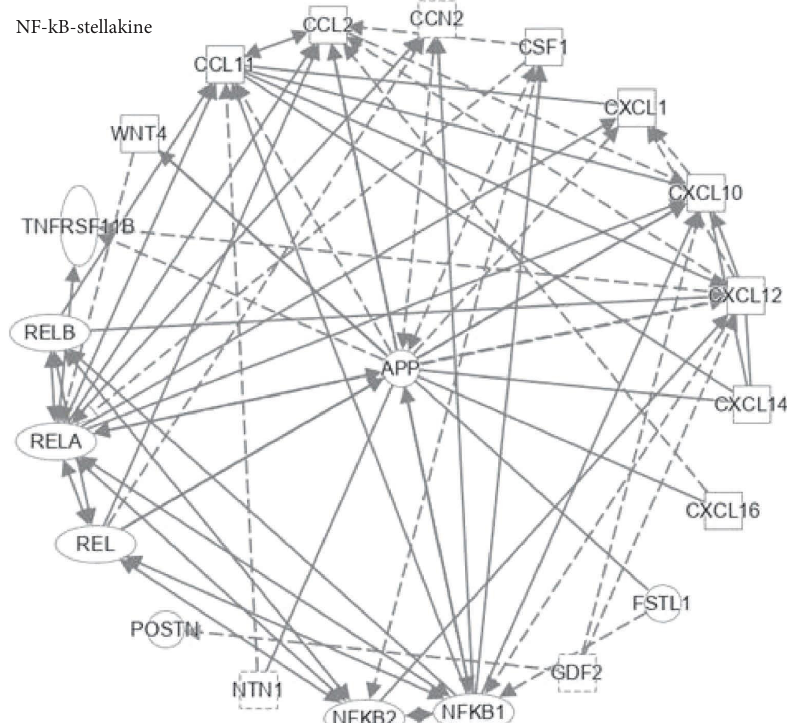
Figure 2: NF- κ B and stellakine. IPA showed the molecular pathways of stellakines and NF- κ B network. APP: amyloid precursor protein, CC chemokines (such as CCL2, CCL11), CSF1: colony stimulating factor 1 (also known as M-CSF), CTGF: connective tissue growth factor (also called CCN2), CXC chemokines (such as CXCL1, CXCL10, CXCL12, CXCL14, CXCL16), GAS6: growth arrest-specific 6, NTN1: netrin-1, POSTN: periostin. Solid lines indicate direct regulation; dashed lines indicate indirect